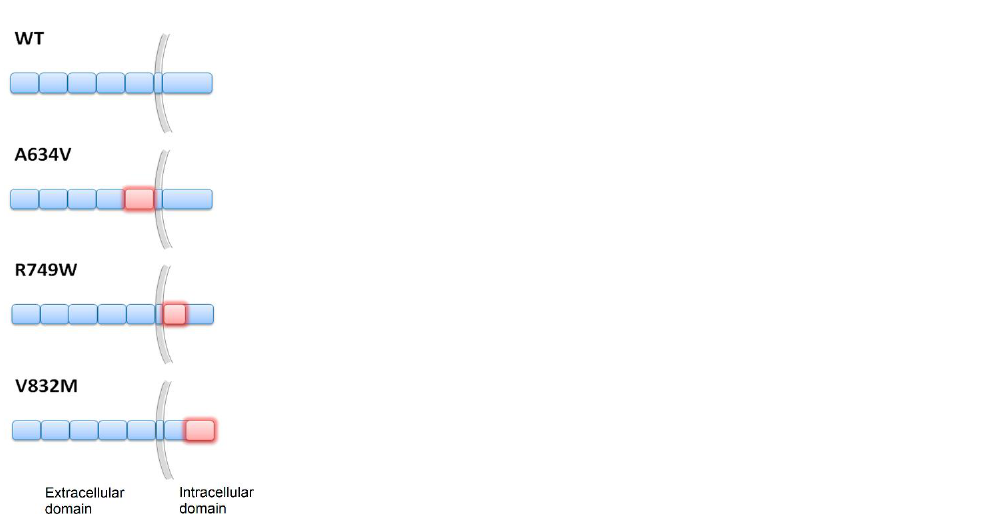
Figure 1. A schematic depiction of the localization of the different E-cadherin mutations (red) tested. Traction microscopy measurements of cells were carried out on Fn + Vt micropatterns, which was described as an advantageous substrate for adhesion of E-cadherin mutant cells. For comparison of M ( t ) between different cells, we normalized M ( t ) with its time average M . Time lapses of M ( t )/ M exhibited erratic temporal fluctuations over the 1-h observation time in all cell types (Figure 2). However, the dynamics of the WT (Figure 2A) and A634V cells (Figure 2B) was less fluctuating than that of the R749W (Figure 2C), V832M (Figure 2D), and Mock cells (Figure 2E).